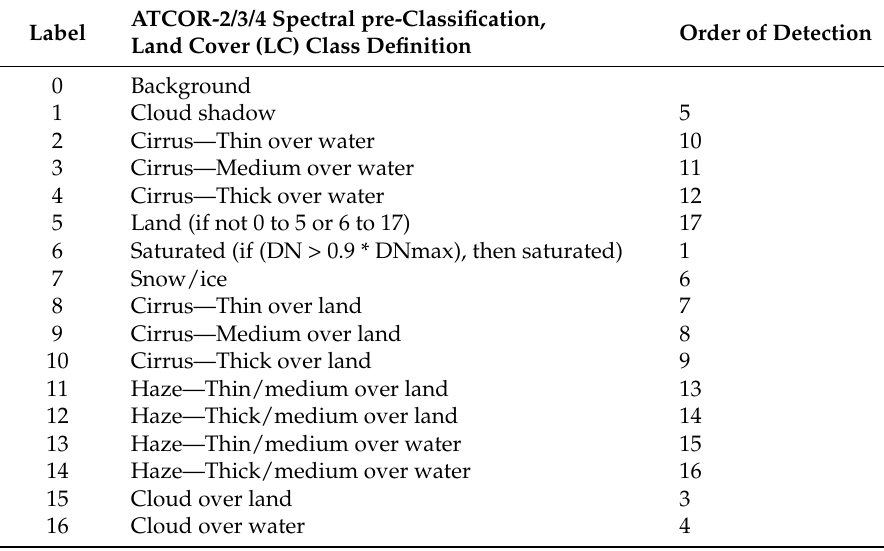
Table 3. Thematic map legend of the ATCOR-2/3/4 spectral pre-classification [71–73], whose output product is identified as “image_hcw.bsq” (hcw = haze/cloud/water and snow) map. According to Richter and Schläpfer, “pre-classification as part of the atmospheric correction has a long history, e.g., as part of NASA’s processing chain for MODIS”, e.g., refer to